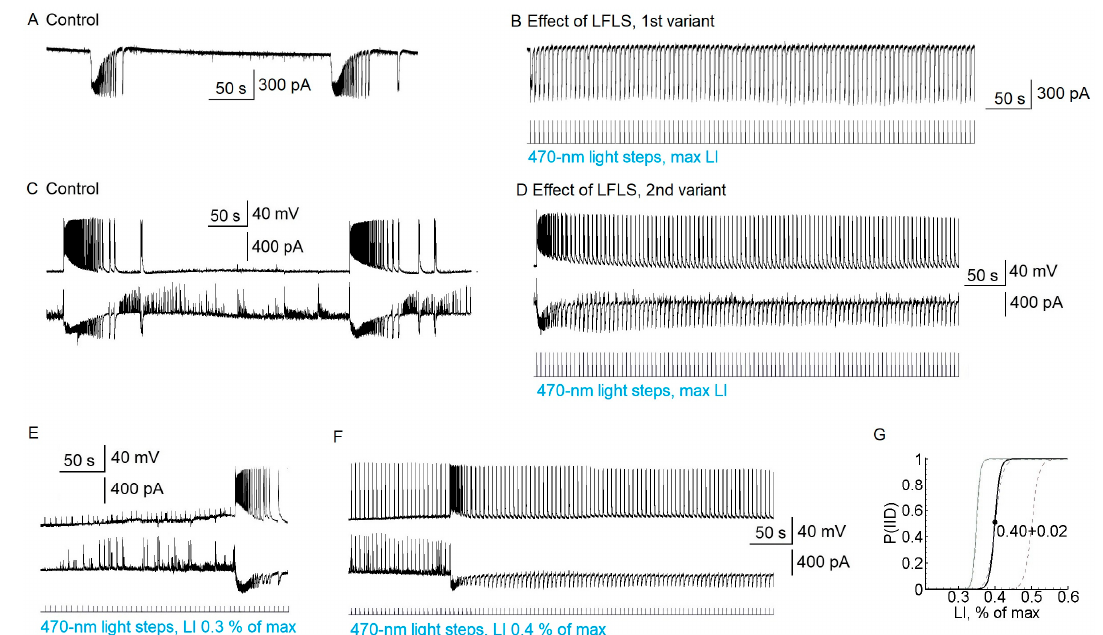
Figure 3. LFLS of excitatory and inhibitory neurons in the entorhinal cortex (Model 1) prevented the generation of ictal discharges but induced interictal discharges; only the first light step could induce ictal discharge. ( A , B ) Representative recordings of the synaptic currents of a pyramidal cell in the control group ( A ) and under LFLS with maximal intensity ( B ) when there were only interictal dis- charges. ( C , D ) Recordings of spiking activity and postsynaptic currents of 2 pyramidal cells in the entorhinal cortex in the control group ( C ) and under LFLS ( D ) when the first light step induced ictal discharge. ( E , F ) Recordings of the same pair of cells shown in ( C , D ) but with subthreshold ( E ) and threshold ( F ) light intensities. The holding potential in the voltage clamp was − 27 mV. ( G ) Sigmoid approximation (Boltzmann fit) of the dependence of the probability to induce interictal discharges by photostimulation on light intensity. The black curve is the averaged approximation ( n = 10), and grey curves are approximations for individual brain slices. The averaged sigmoid was calculated as 𝑃(𝐼𝐼𝐷) = 1 − (cid:2869) , where 𝐿𝐼 (cid:2868) = 0.40 ± 0.02% of the maximum, and ∆ = 0.007 ± 0.0008% of the (cid:2869)(cid:2878)(cid:3032) ((cid:3261)(cid:3258)(cid:3127)(cid:3261)(cid:3258)(cid:3116))/∆ maximum.